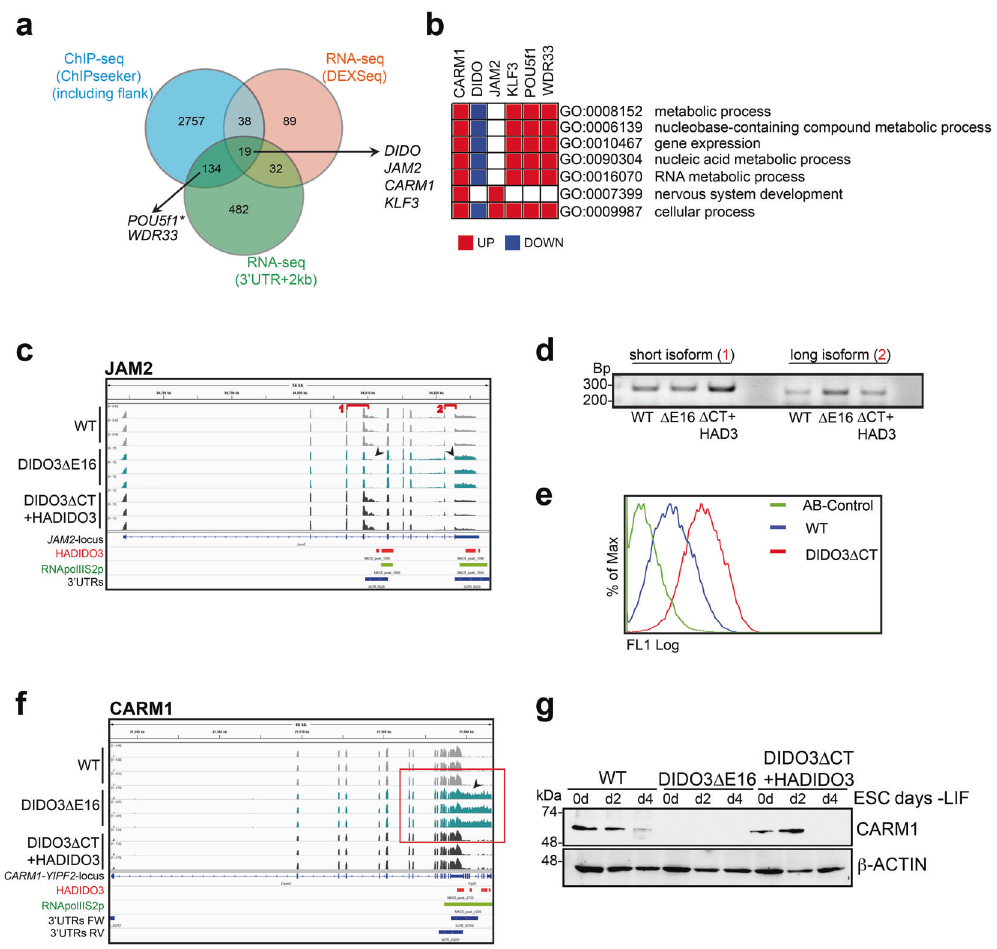
Fig. 2 DIDO3 Δ E16 ESC expression alterations detected by RNA-seq, with effects on protein expression. a The Venn diagram depicts the relationship of genes identi fi ed for altered expression in DIDO3 Δ E16 ESC compared to WT, and restored in DIDO3 Δ CT + HADIDO3 in RNA-seq (DEXSeq, Supplementary Table 1; 3 ′ UTR + 2 kb, Supplementary Table 2), and a DIDO3 DNA-binding site determined by ChIPseeker of previous ChIP-seq data (Supplementary Table 3); some relevant examples are highlighted. Note: (*) Signi fi cant alteration (1.5-fold difference; FDR < 0.05) was not detected by RNA-seq data analysis, but RT-PCR con fi rmed a prolonged 3 ′ UTR of the transcript only in the DIDO3 Δ E16 mutant ESC. For details, see Results. b GO term enrichment analysis and heatmap of the selected genes. UP- and DOWN regulated genes in DIDO3 Δ E16 versus WT are shown in red and blue, respectively. Signi fi cantly enriched GO terms (biological processes) were identi fi ed using DAVID (https://david. ncifcrf.gov/), g: Pro fi ler (https://biit.cs.ut.ee/gpro fi ler/gost), and GSEA (https://www.gsea-msigdb.org/). For additional details of the enrichment analysis, see Supplementary Fig. 1d. c JAM2 example gene; IGV image shows the JAM2 locus, aligned and normalized RNA-seq reads of triplicates of WT, DIDO3 Δ E16, and DIDO3 Δ CT + HADIDO3 ESC as well as DIDO3 ChIP-seq peaks (red) with overlapping RNA pol II S2p peaks (green) and de fi ned 3 ′ UTR regions (blue). d Different abundance of JAM2 short isoform1 and long isoform2 (indicated in c), con fi rmed in WT, DIDO3 Δ E16, and DIDO3 Δ + HADIDO3 RNA as tested by RT-PCR. e The histogram shows abundance of the JAM2 protein in WT and DIDO3 Δ CT ESC as measured by fl ow cytometry analysis after anti-JAM2 antibody staining. f CARM1 example gene; parameters as in ( b ) for the CARM1 locus, focusing on 3 ′ UTR read-throughs in the DIDO3 Δ E16 mutant (red box). g Western blot analysis of lysates of ESC and embryonic bodies without LIF at d2 and d4, comparing CARM1 protein levels in WT, DIDO3 Δ E16, and DIDO3 Δ CT + HADIDO3 cells; β -ACTIN used as loading (Supplementary Table 1; Supplementary Fig. 1a). As predicted, DIDO was among the genes found and RNA-seq data con fi rmed the reported lack of splicing to the DIDO1 isoform [23, 28]; HADIDO3 reconstitution restored DIDO1 expression (Supplemen- tary Fig. 1b). For observed 3 ′ UTR read-throughs of transcripts, we reanalyzed the RNA-seq data and calculated expression differences with 2 kb added downstream of the de fi ned 3 ′ UTRs. Genes whose expres- sion of prolonged 3 ′ UTR in DIDO3 Δ E16 recovered normal levels after reconstitution with HADIDO3 are shown (Supplementary Table 2).